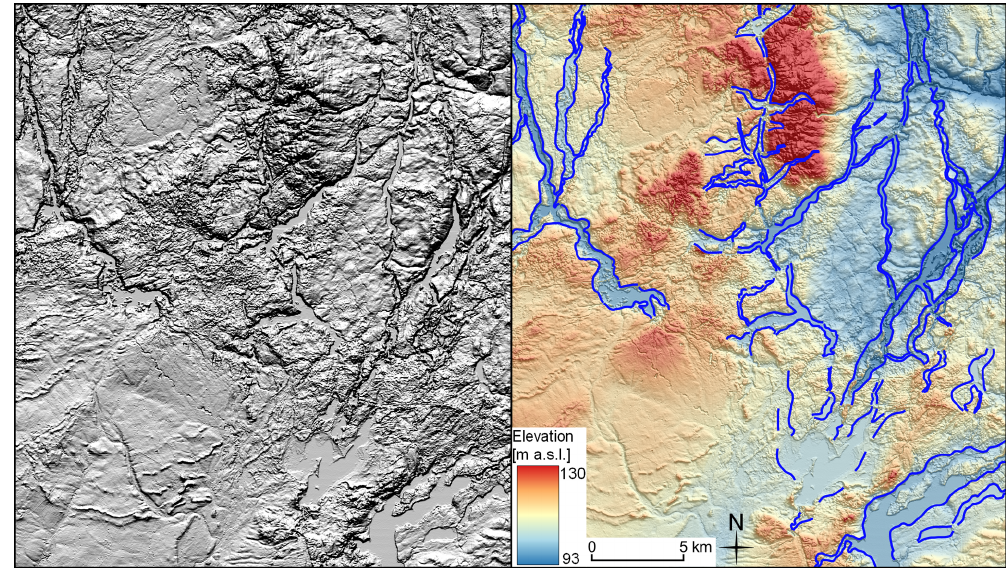
Figure 10. Examples of tunnel valleys as plain hillshade model (left) and DEM superimposed on hillshade model